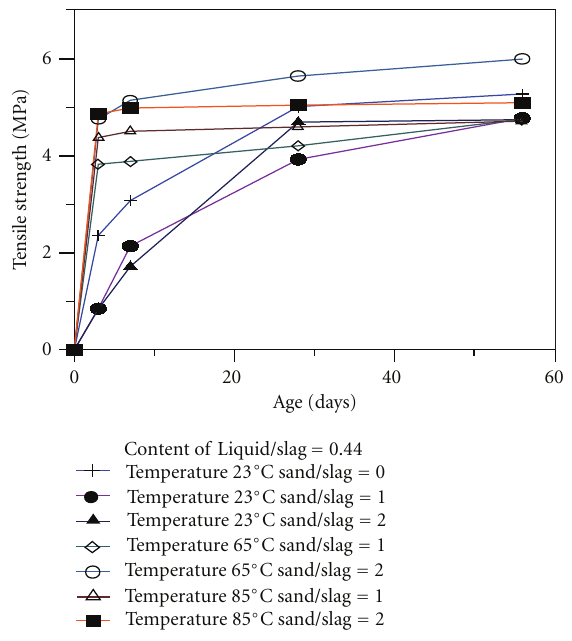
Figure 5: Tensile strength of AAS mortars ( L/S = 0 . 44).